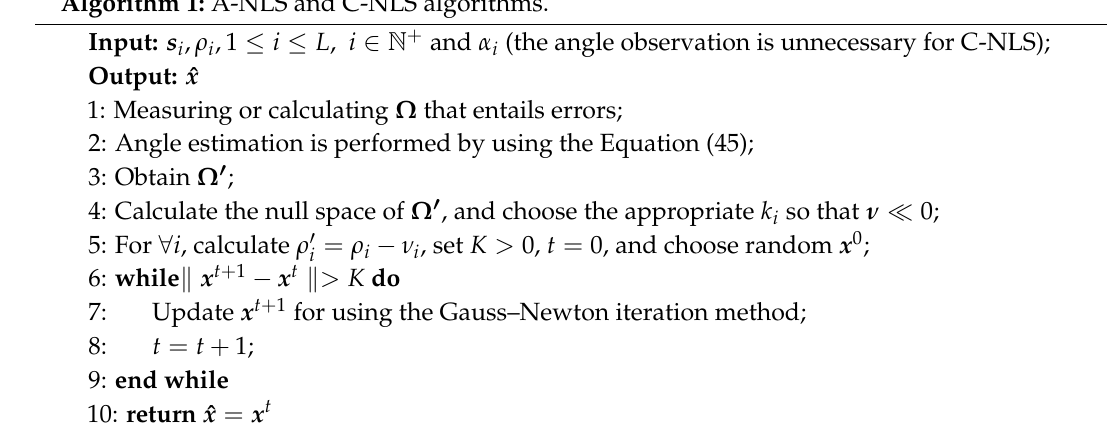
Algorithm 1: A-NLS and C-NLS